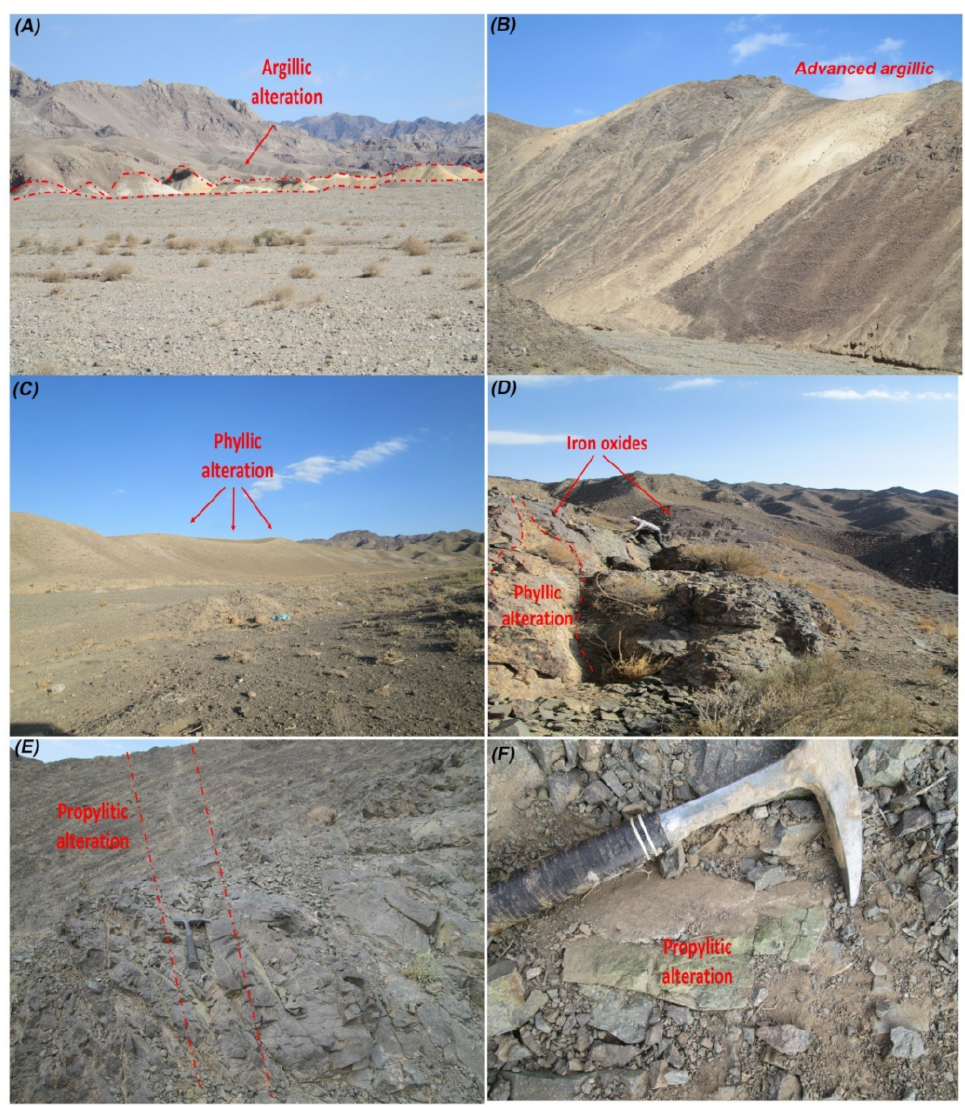
Figure 10. Field photographs of the hydrothermal alteration zones in the study area. ( A ) A panoramic view of argillic alteration zones; ( B ) a view of the advanced argillic alteration zone; ( C ) a regional view of the phyllic alteration zone; ( D ) a regional view of hematite-rich altered oxidized zones in association with phyllic alteration zones; ( E ) a view of the propylitic zone; ( F ) a close up of a specimen from the propylitic alteration